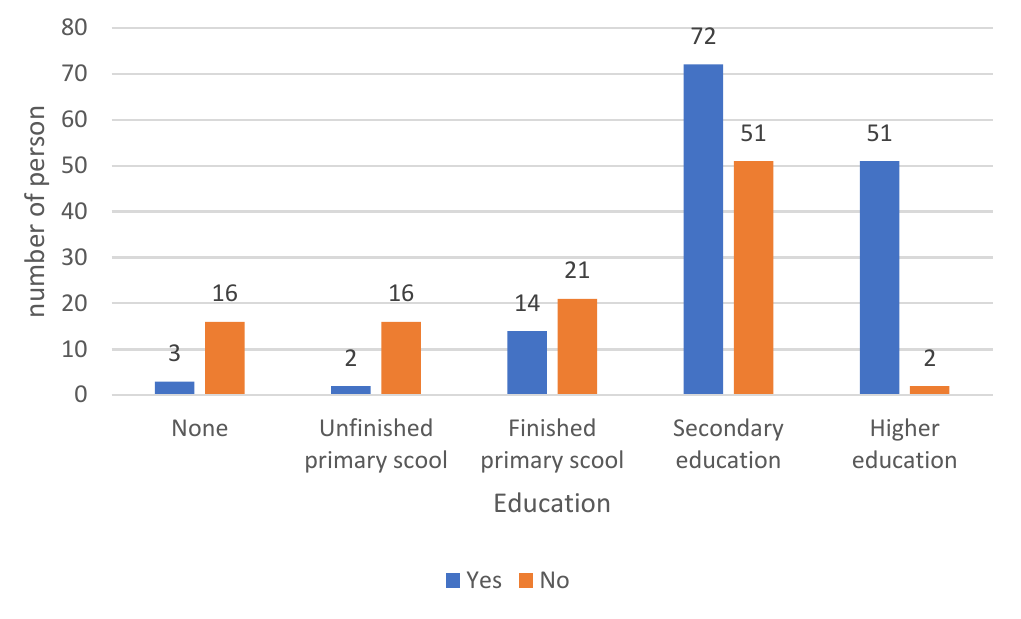
Figure 4. Number of people knowing the cause of malaria by education. Respondents with higher education were significantly more likely to know the symp- toms of malaria (96%) p < 0.001.